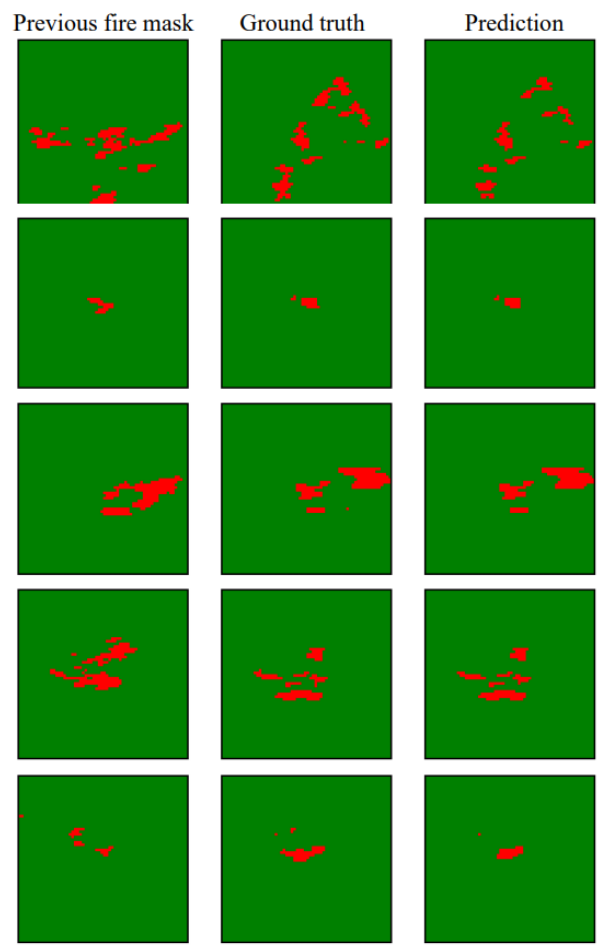
Figure 5 . Qualitative results generated by the multi-kernel CNN